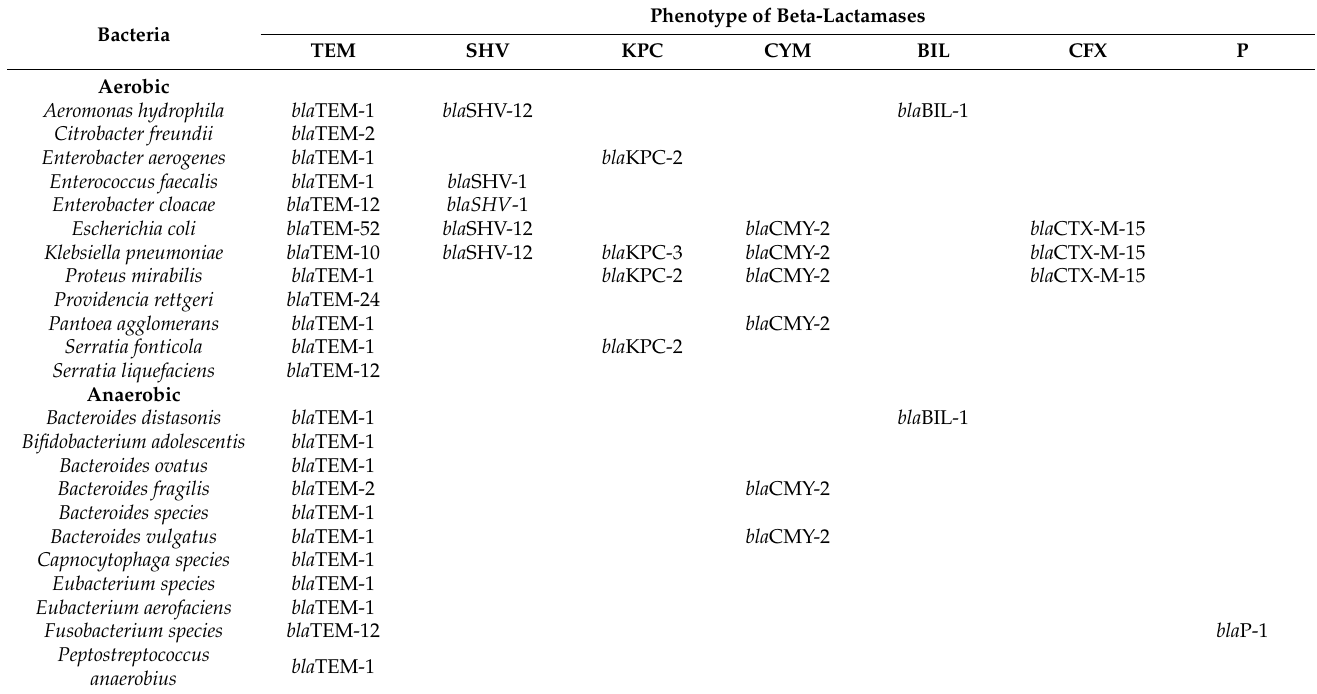
Table 6. Mixed Genotype of the beta-lactam antibiotic resistome identified by next-generation sequencing in the aerobic and anaerobic Enterobacteria from feces of humans in healthy conditions.